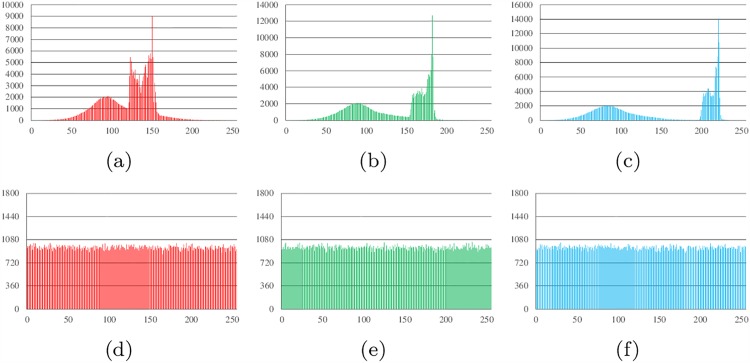
Histogram analysis results of mountain.(a) Histogram of red channel of mountain; (b) Histogram of green channel of mountain; (c) Histogram of blue channel of mountain; (d) Histogram of red channel of cipher; (e)Histogram of green channel of cipher (f)Histogram of blue channel of cipher.